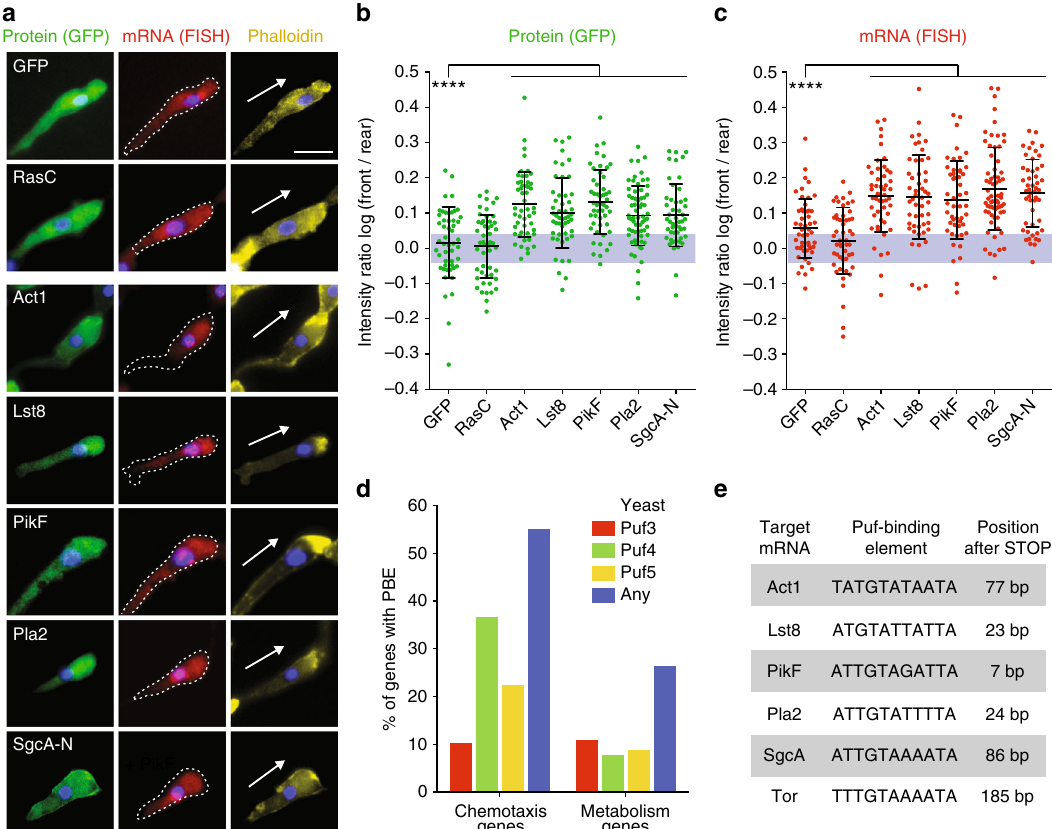
Fig. 1 Four chemotaxis pathway mRNAs and proteins localize to the cell front in chemotaxis. a Localization of GFP-tagged proteins and corresponding mRNAs in cells expressing GFP-RasC, -Act1, -Lst8, -PikF, -Pla2, the N-terminal 1019 residues of SgcA (SgcA-N) and GFP control in natural chemotactic streams. Chemotaxis pathway genes were expressed with their endogenous 3 ′ -UTRs. Arrow indicates orientation of cell polarity de fi ned by F-actin stain (Alexa Fluor 647-conjugated Phalloidin). DNA (nucleus) was stained with DAPI. Note that some GFP-mRNAs were also localized in bright foci within the nucleus, which represent sites of transcription. Scale bar, 10 μ m. b , c Quanti fi cation of the fl uorescence intensity ratio of each GFP-tagged protein and mRNA between the front and rear of the cell, and represented as a log of the log F/R. The gray area indicates values equivalent to symmetric localization (between log(0.9) and log(1.1)). Mean and standard deviation (SD), n ≥ 50 cells. Mann – Whitney test: **** p < 0.0001. d Percentage of genes annotated with the function “ chemotaxis ” (97 genes) or “ metabolism ” (57 genes) in Dictybase with PBEs de fi ned by consensus sites for yeast Puf3, Puf4, Puf5 or any of them within 330 base pairs after STOP codon (Supplementary Fig. 2). e Pumilio-binding elements (PBEs) in the 3 ′ -UTR of genes involved